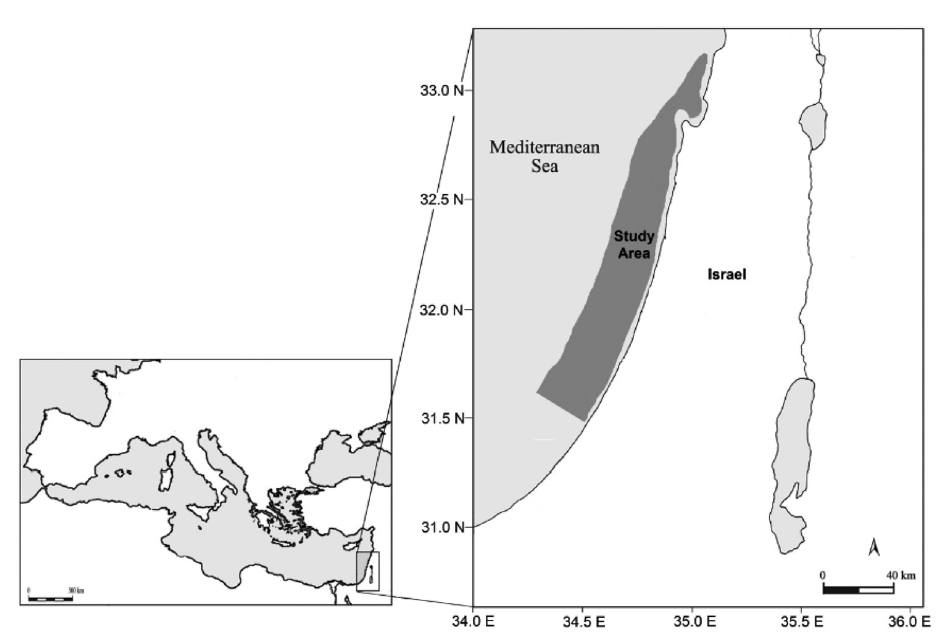
Fig. 1. – Map of the study area and Israeli trawling grounds (adapted from Edelist et al.